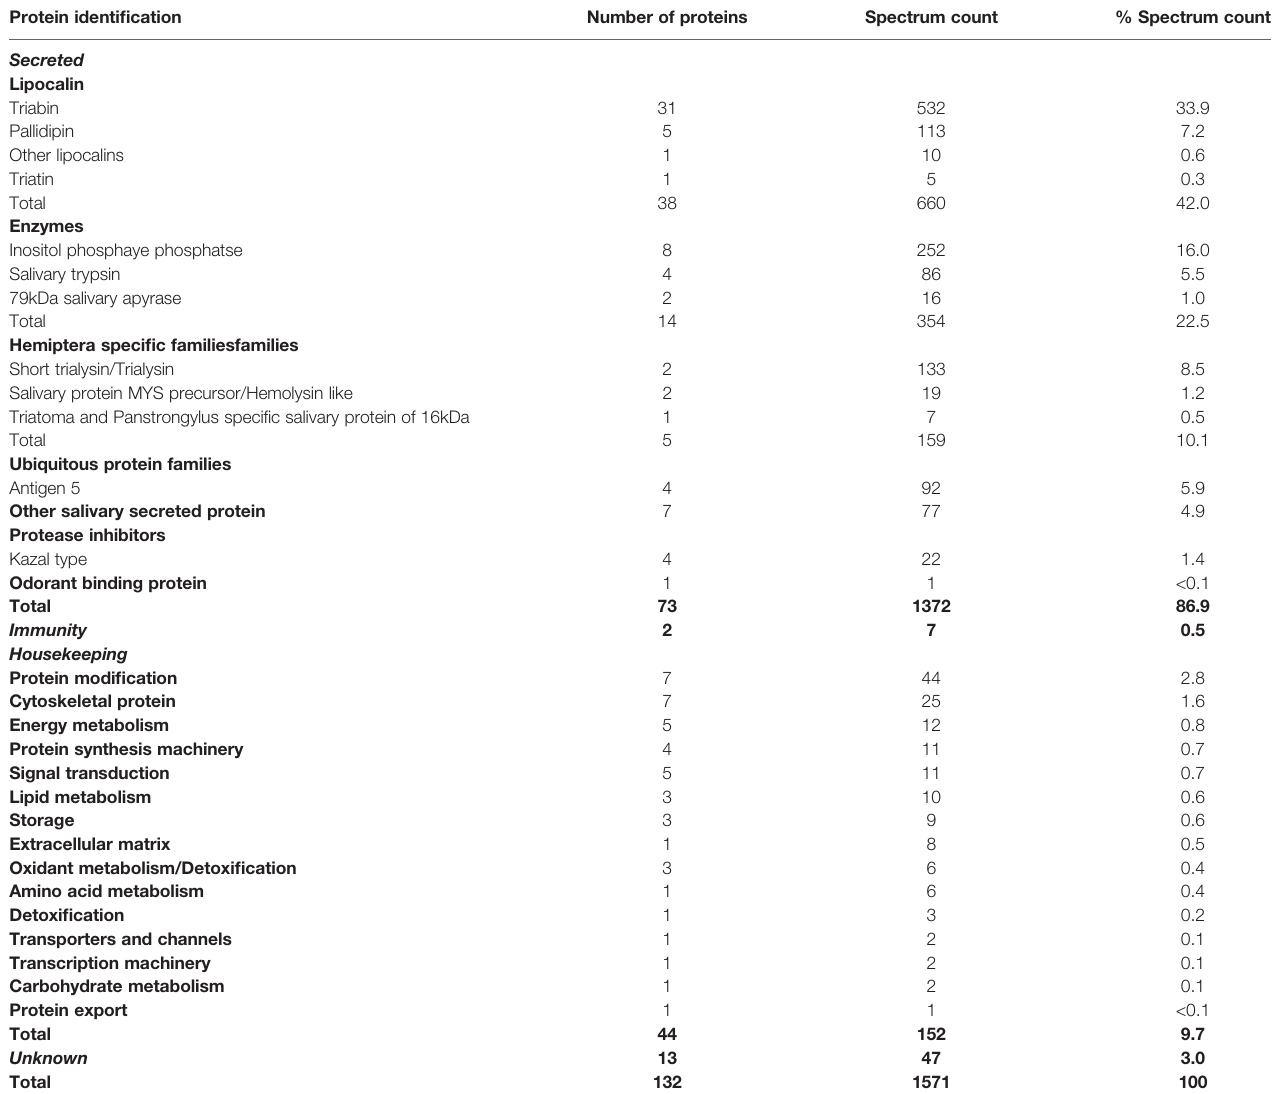
The values in bold correspond to the total for each class, group or